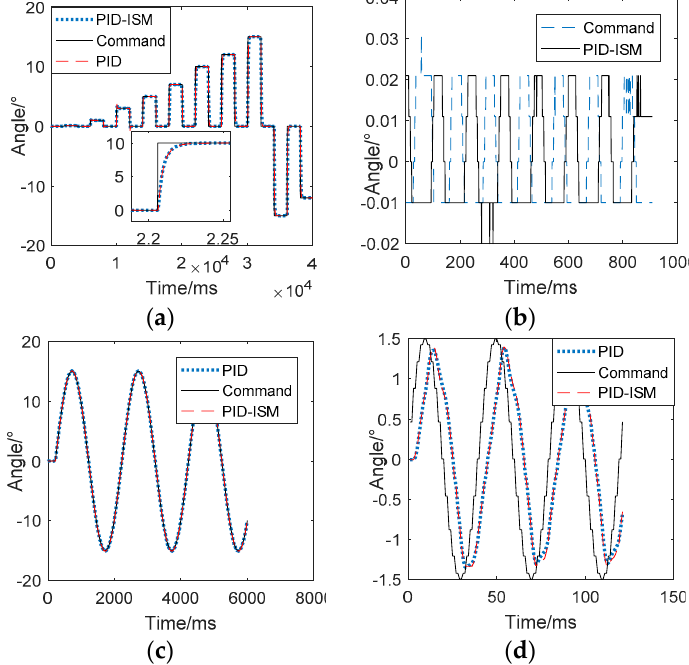
Figure 8. The comparisons of traditional PID and PID-ISM. ( a ) Step response. ( b ) Steady-state errors. ( c ) Position tracking by using PID and PID-ISM. ( d ) Thebandwidth test.